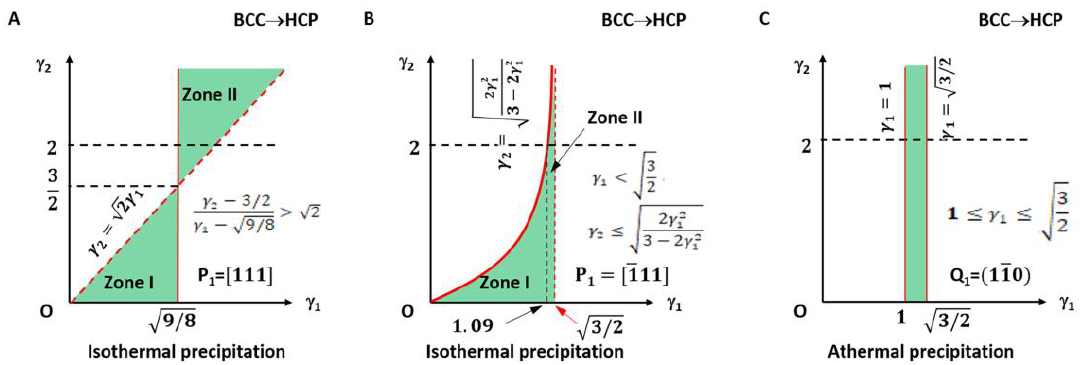
Figure 3. Lattice parameter applicable range (green colour) for BCC-to-HCP transformation of isothermal ( A , B ) and athermal ( C ) precipitation. ( A ) Triangular zones I and II for isothermal type I. ( B ) Right side of quadratic curve for isothermal type II. Dashed line indicates forbidden line. ( C ) Rectangle zone of athermal